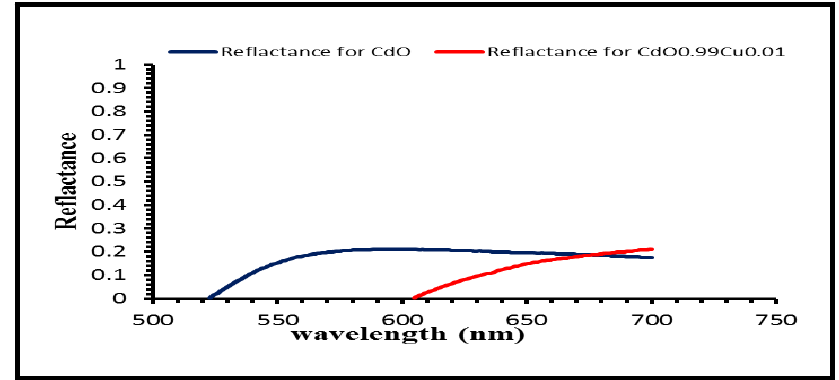
Fig.6: Reflectance of CdO and CdO